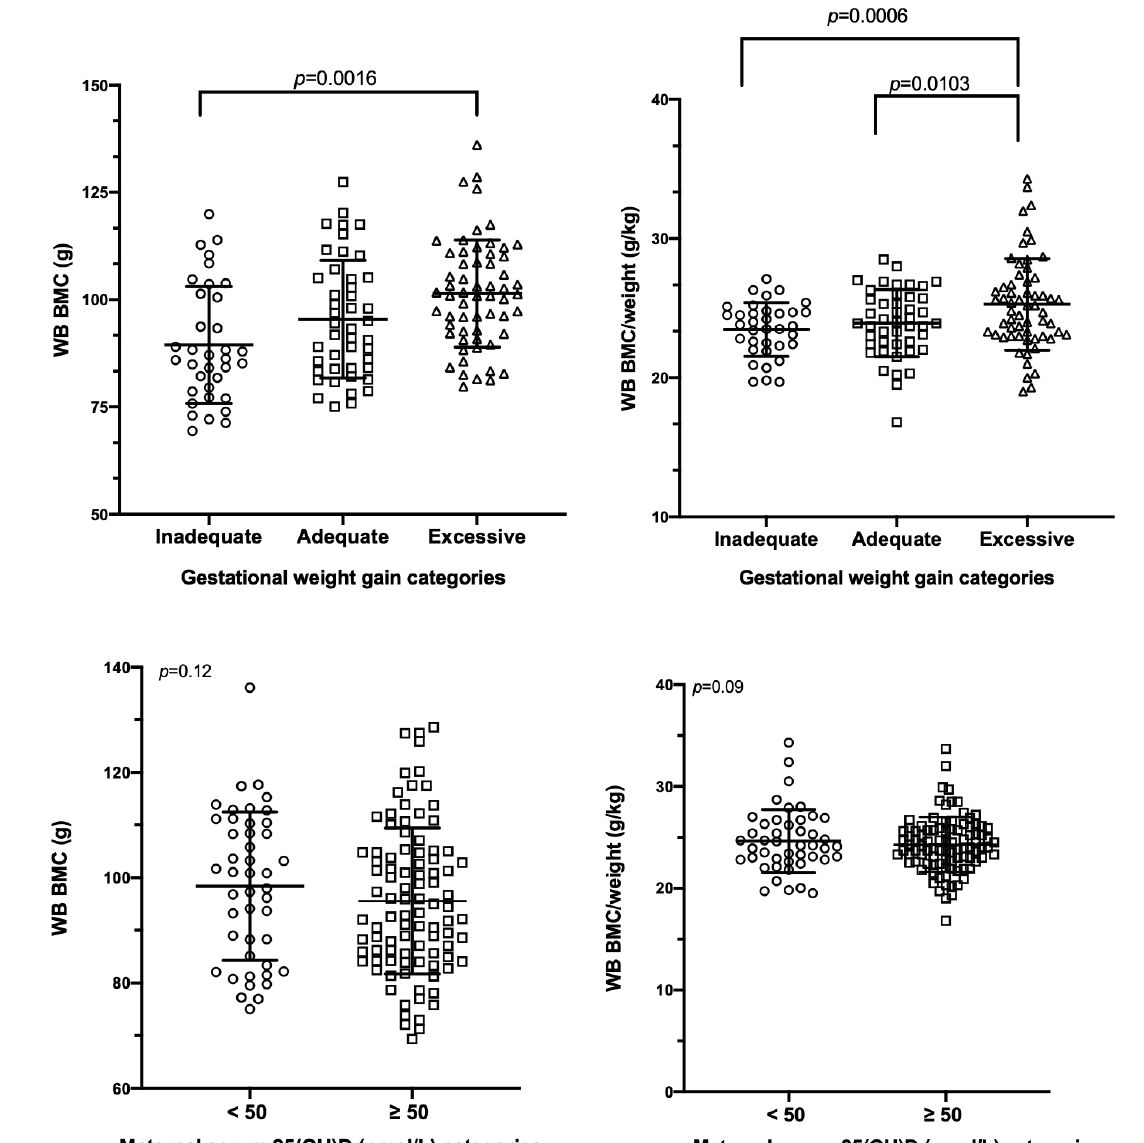
Figure 3. Whole-body bone mass in the neonatal period according to gestational weight gain categories and